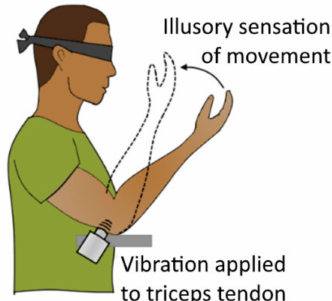
Figure 12. Example of a vibration-induced kinaesthetic illusion of movement: vibration of triceps tendon induces an illusion of elbow flexion. The vibration of muscle tendon activates the muscle proprioceptors and causes an illusion of a sense of joint